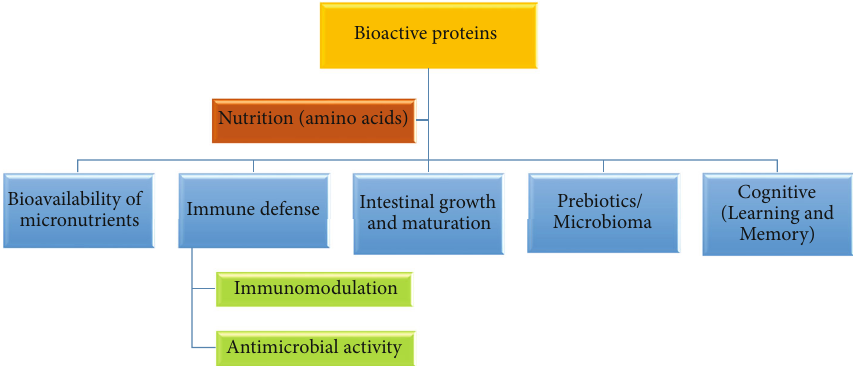
Figure 3: Biological functions of bioactive proteins present in human milk. Adapted from